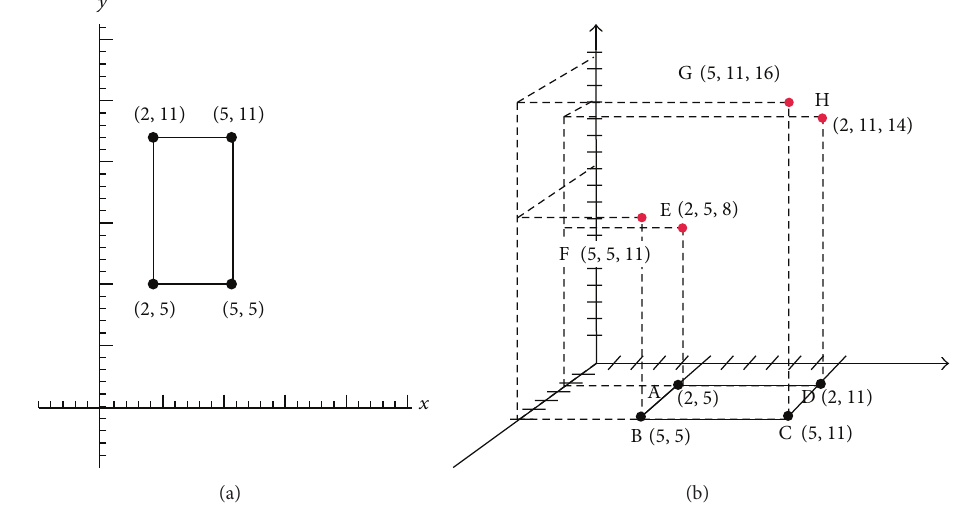
Figure 2: Example of a rectangle 𝑅 2 in hyperrectangle model.